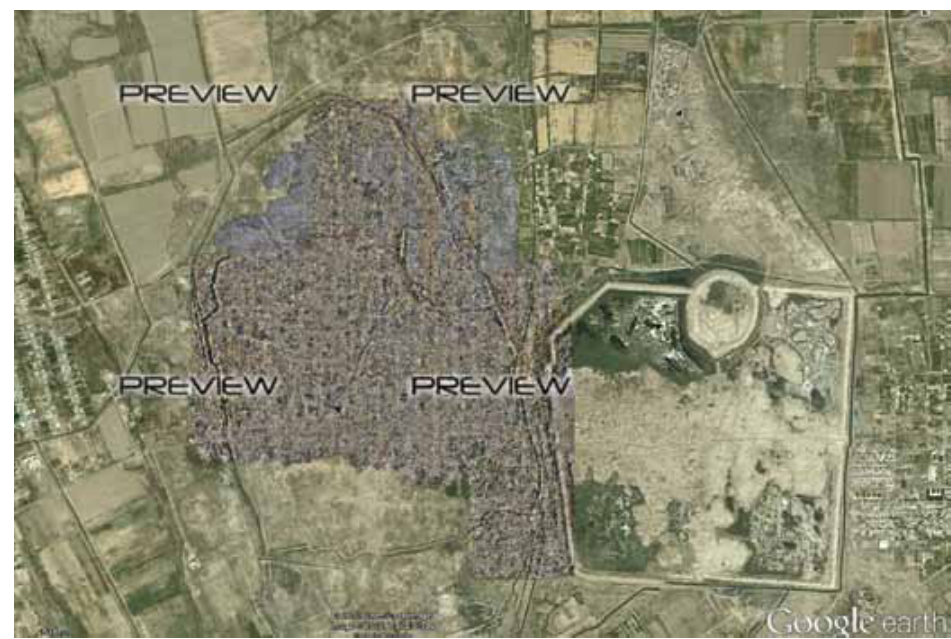
Fig. 13: A low resolution preview of the orthomosaic, as a kml within Google Earth, giving some indication of the coverage of the image, although not of its